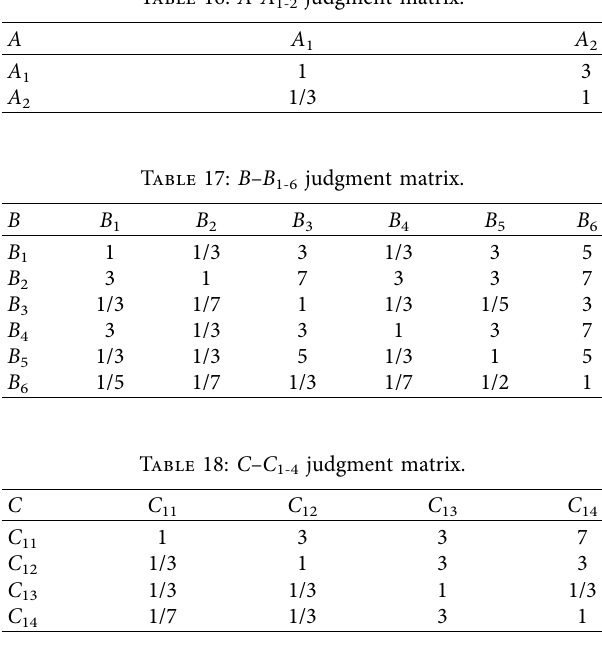
Table 16: A - A 1-2 judgment matrix.